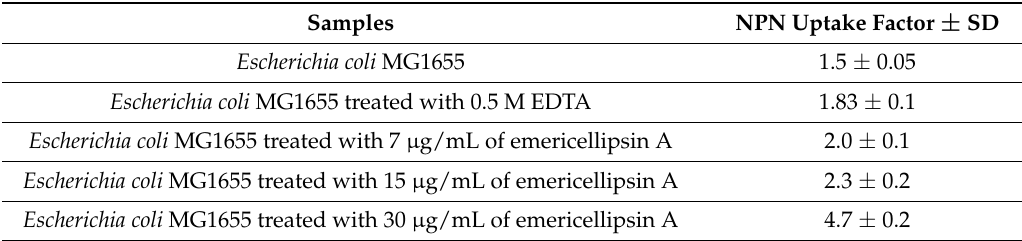
Table 2. 1- N -phenylnaphthylamine (NPN) uptake of Escherichia coli MG 1655 induced by permeabilizers.